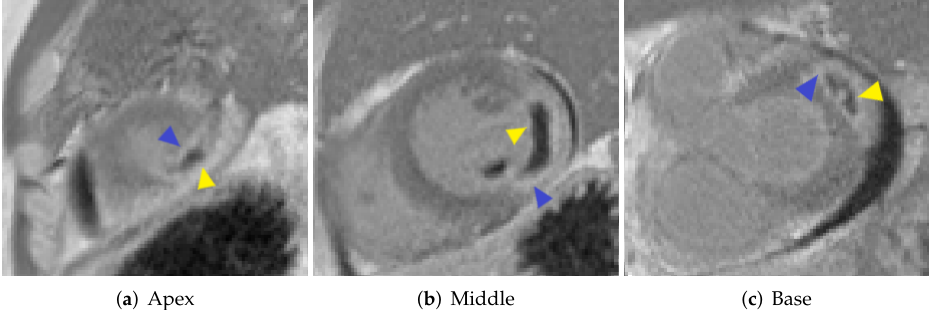
Figure 1. Short-axis LGE-MR images show MI (blue triangular) and MVO (yellow